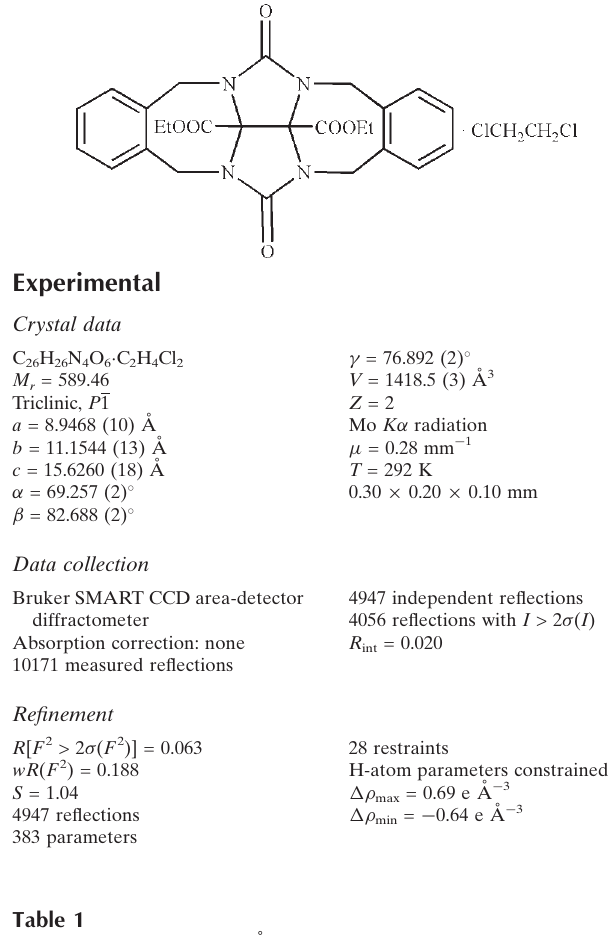
Hydrogen-bond geometry (A˚ , (cid:3)